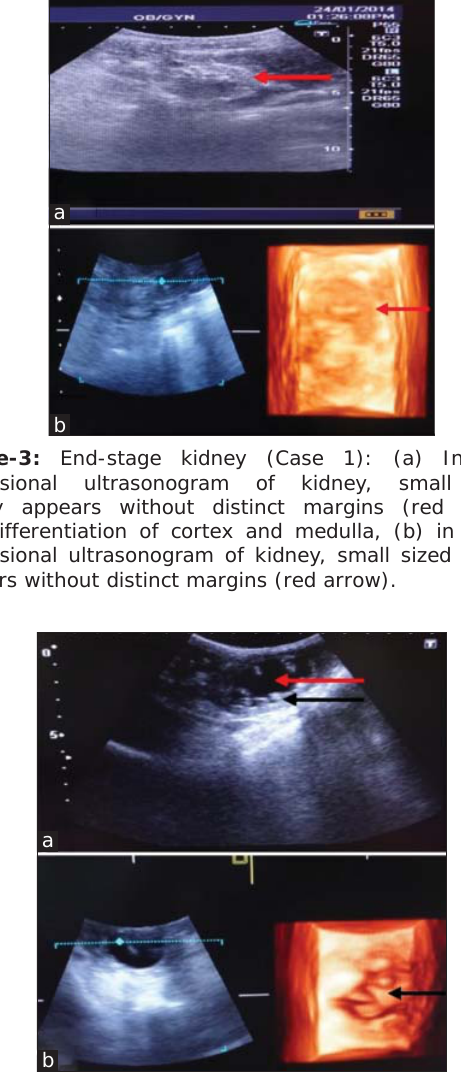
Figure-4: Hydronephrosis Case 1: (a) In two-dimensional ultrasonogram of kidney with dilated renal pelvis (red arrow). Atrophied renal parenchyma with loss of architectural details (black arrow), (b) in three-dimensional ultrasonogram dilated renal pelvis (red